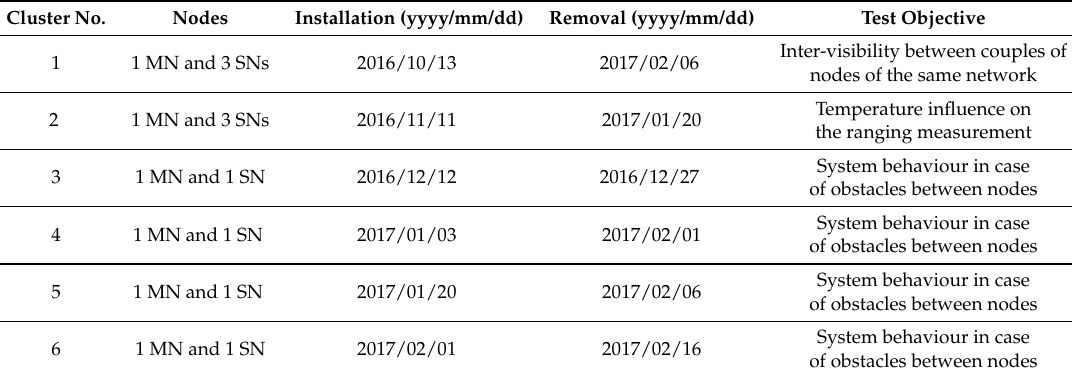
Figure 6. High resolution digital elevation model (DEM) of Arcetri Test site: clusters and node positions. Master nodes (MNs) are indicated with number 1. Table 2. Clusters details of Arcetri Test